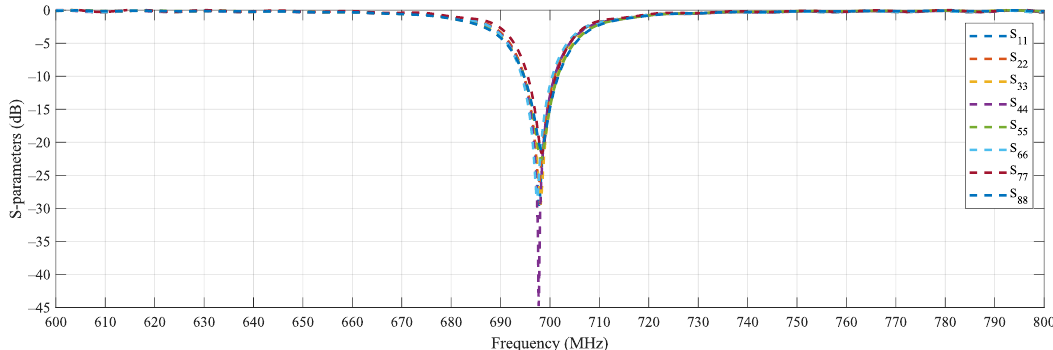
Figure 4. S-parameters of the array elements. All S-parameters are ≤− 21 dB at 698 MHz (DVB-T channel 49 center frequency) satisfying the optimization